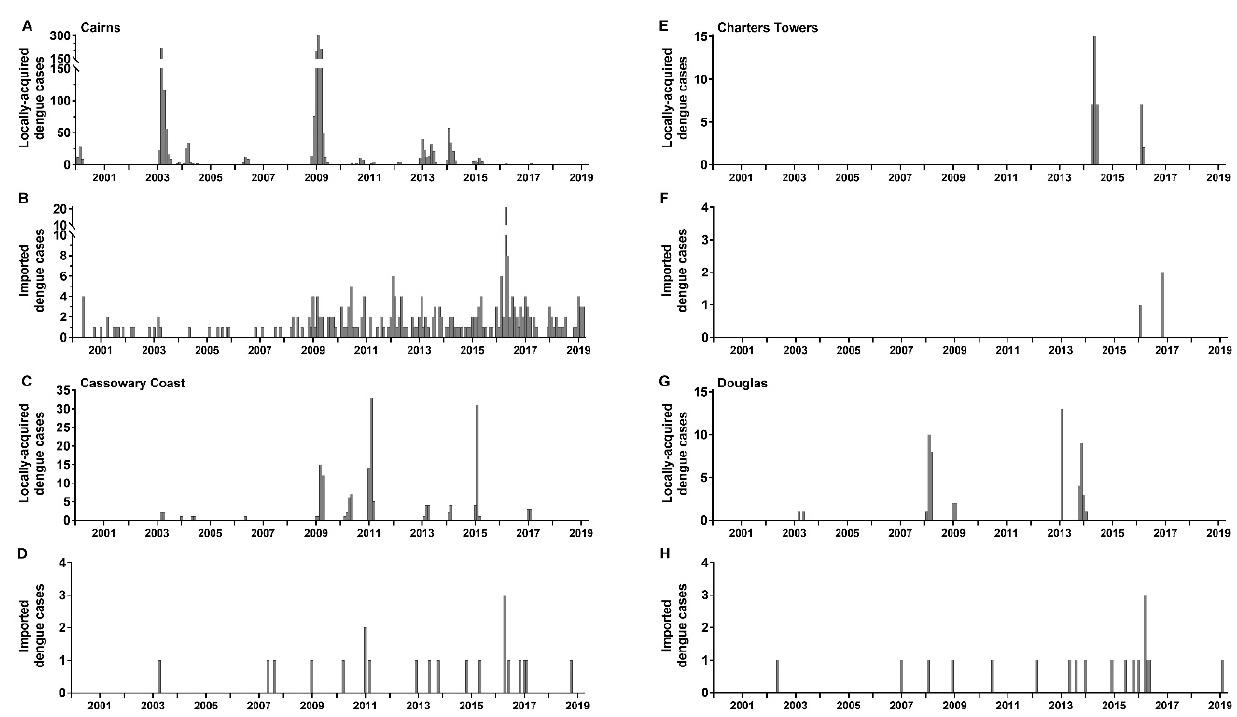
Figure 16. Dengue case notifications per month, January 2000 – March 2019, in four local government areas where Wolbachia mosquitoes have been released. Notifications include laboratory-confirmed and probable dengue cases, classified as locally-acquired ( A , C , E , G ) or imported ( B , D , F , H ) based on a history of overseas travel to a dengue-affected country during the period 3 – 12 days prior to illness onset. Case location was determined from geolocated address information from the Cairns and Townsville public health unit operational databases, where available, otherwise from suburb in the NoCS case record.